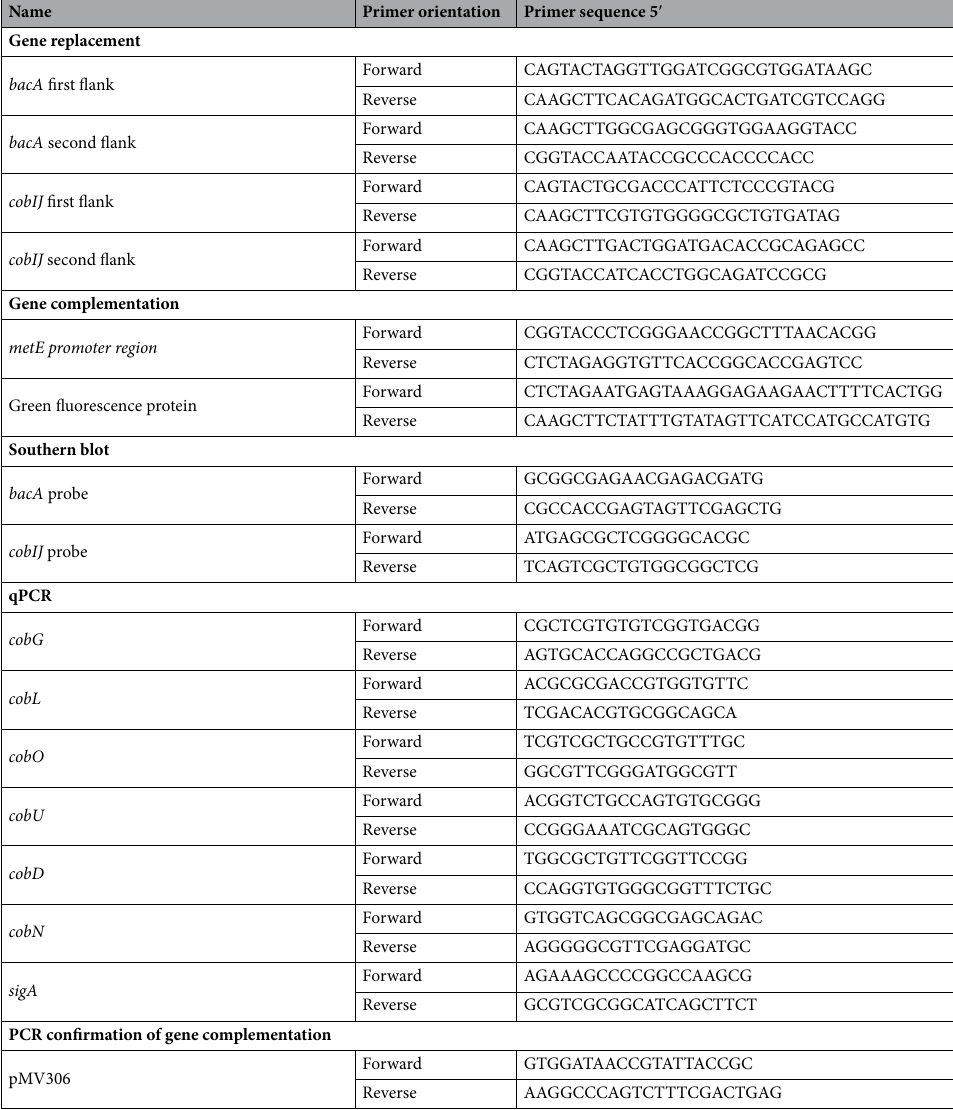
Table 5. List of primers used in this